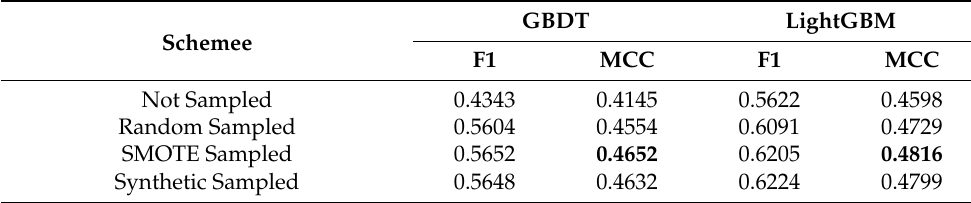
Table 6. Performance comparison of different oversampling schemes.